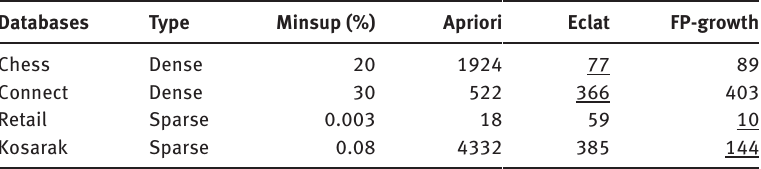
Table 1. Execution Time on Sparse and Dense Databases.